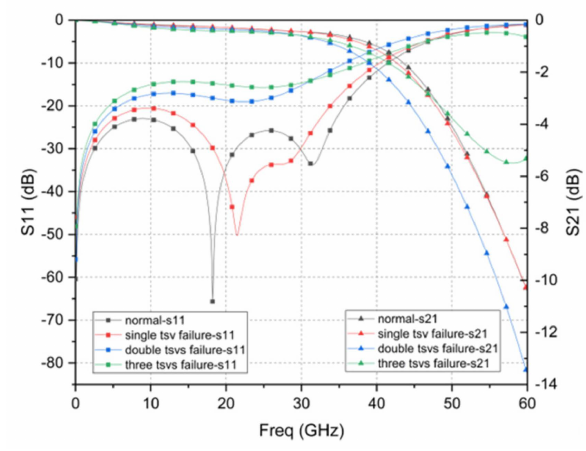
Figure 7. Quad redundant TSV failure simulation results.